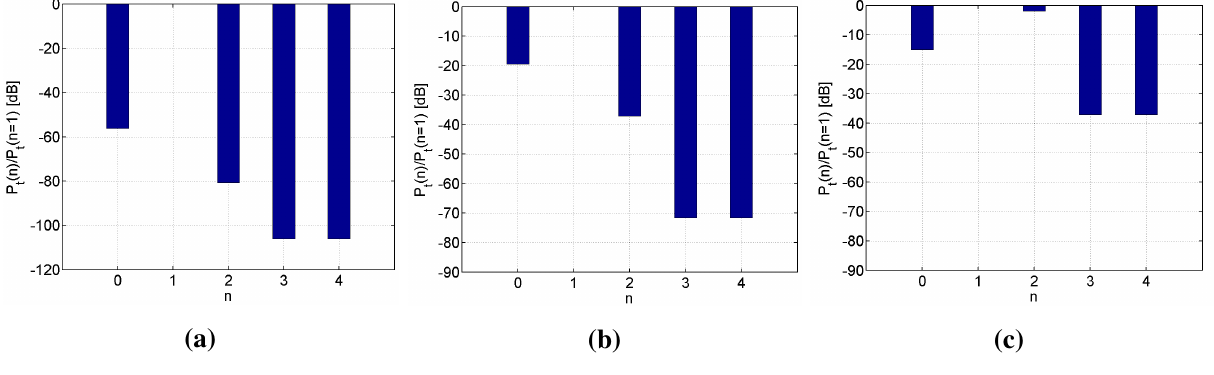
Figure 3. The total power spectrum of the n -th mode, i.e. , the total power in the n = 0 , 1 , 2 , 3 and 4 modes, normalized by the the total power in the dipole ( n = 1 ) mode. ( a ) Concentric 3L NP, κ = − 0 . 4409 , 538 . 7 nm; ( b ) eccentric 3L NP, κ = − 0 . 4409 , 538 . 5 nm; ( c ) eccentric 3L NP, κ = − 0 . 4409 , 421 . 0 nm. For the eccentric cases, the core is displaced by an amount = − 5 nm. Refer to the main text for more of x 13